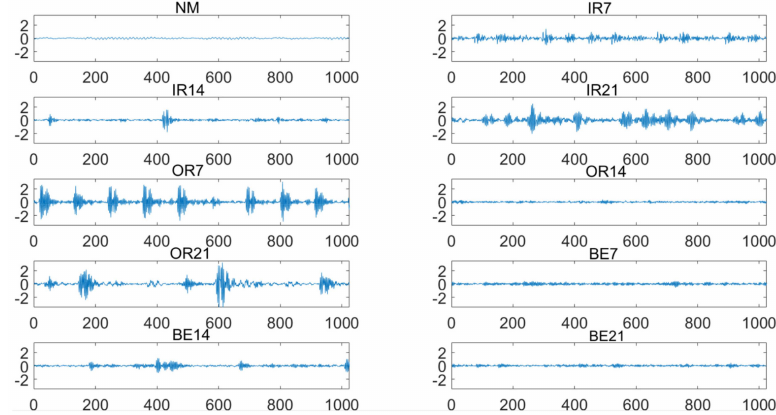
Figure 3. The time-domain waveforms of rolling bearing vibration signals with di ff erent types and fault severity under 0 load. Table 1. The composition of fault types and fault severity in the experimental sample